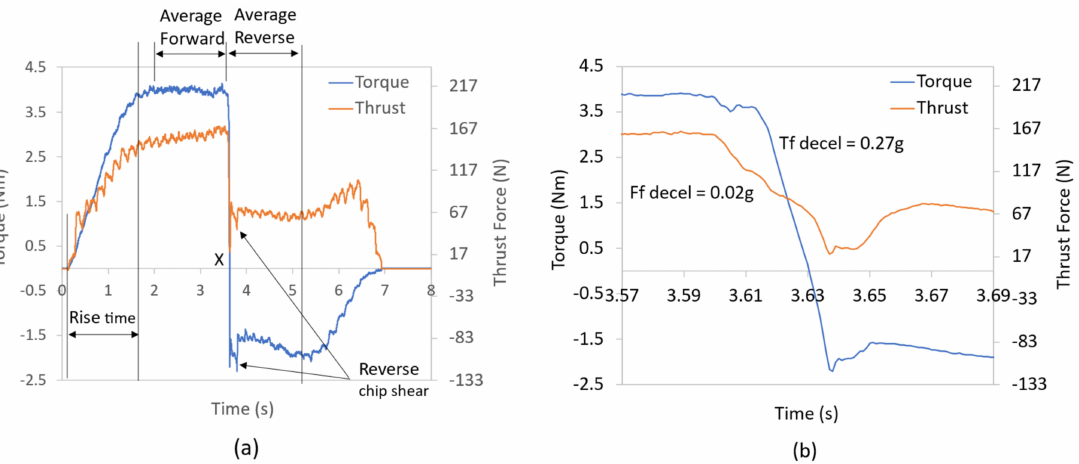
Figure 5. Typical test result filtered at 300 Hz with characterisation of performance measures Tf, Tr, Ff and Fr ( a ), and deceleration at the end of forward stroke ( b ).